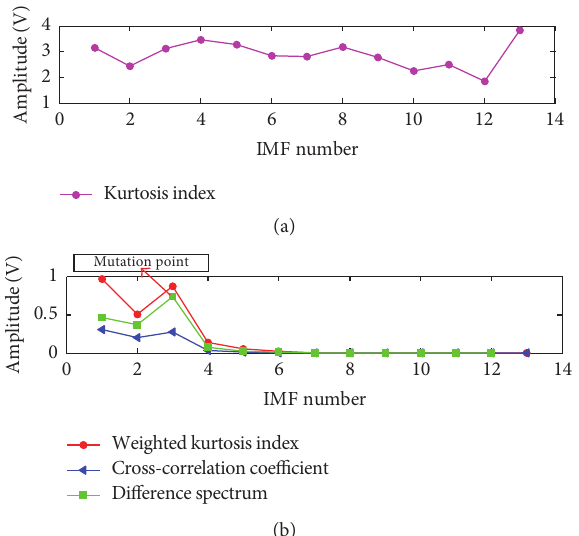
Figure 15: WKIDS of the inner race of the bearing: (a) kurtosis index; (b) weighted kurtosis index, cross-correlation coefficient, and difference spectrum.